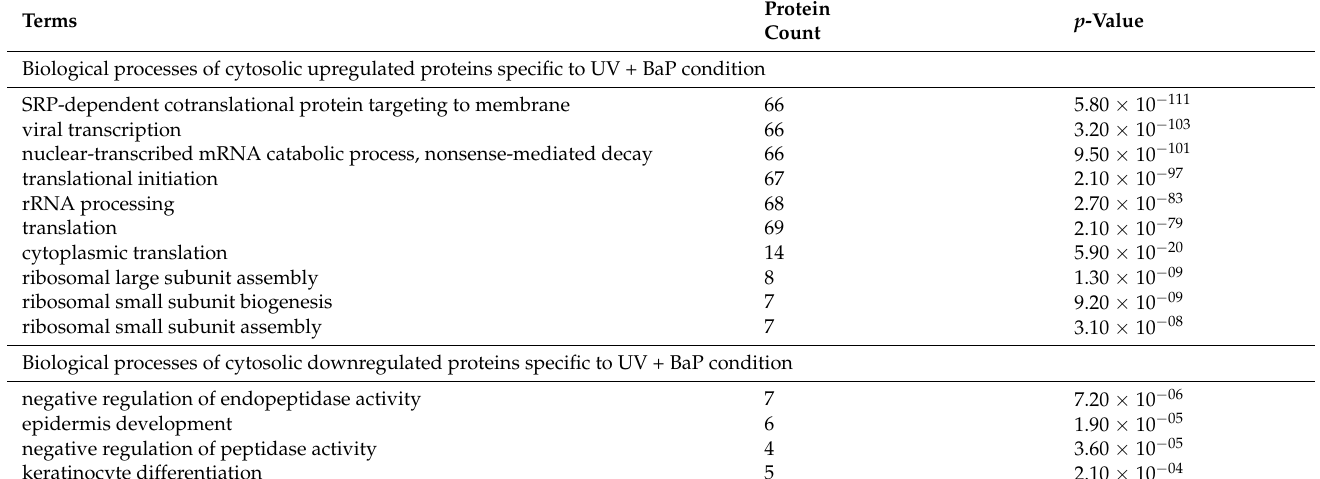
Table 1. List of the dysregulated biological processes following UV + BaP co-exposure compared to UV exposure alone. The top 10 dysregulated biological processes are indicated for upregulated or downregulated proteins from cytosolic, cell membrane and nuclear extracts. Count indicates the number of proteins involved in each biological